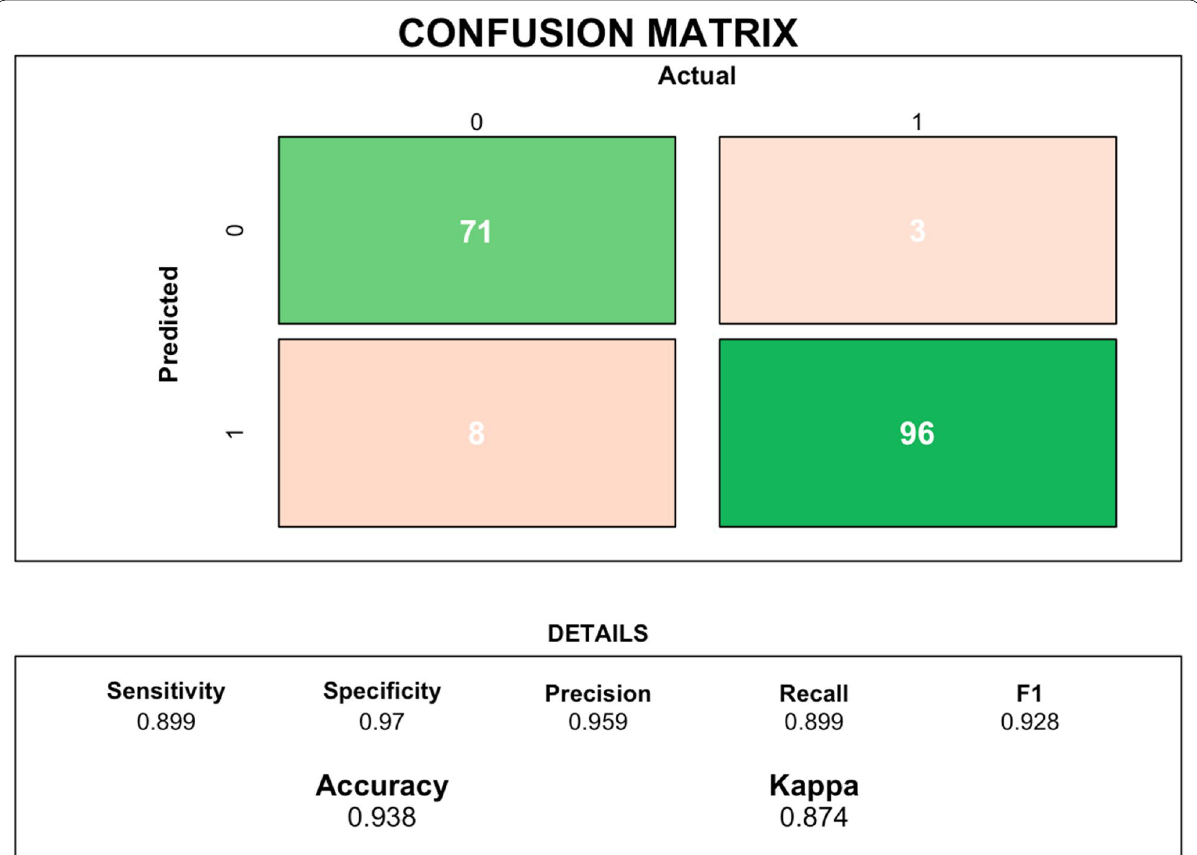
Fig. 3 To further probe the ability of CAT12 scores to accurately classified inclusion/exclusion of MRI images (derived from our human raters), confusion matrices were constructed. Of note, 80% of our data was used in our training set and 20% in our test set. This graphic displays the different metric of accurate classification including sensitivity, specificity, accuracy, and